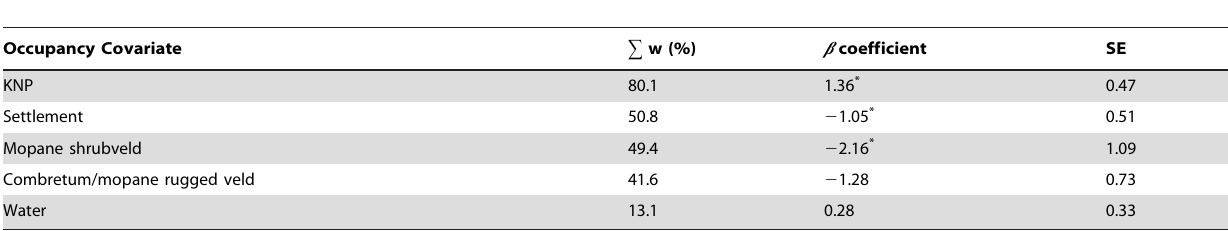
(cid:2)^ yy ^ yy ) in order of their summed model weights ( g w).